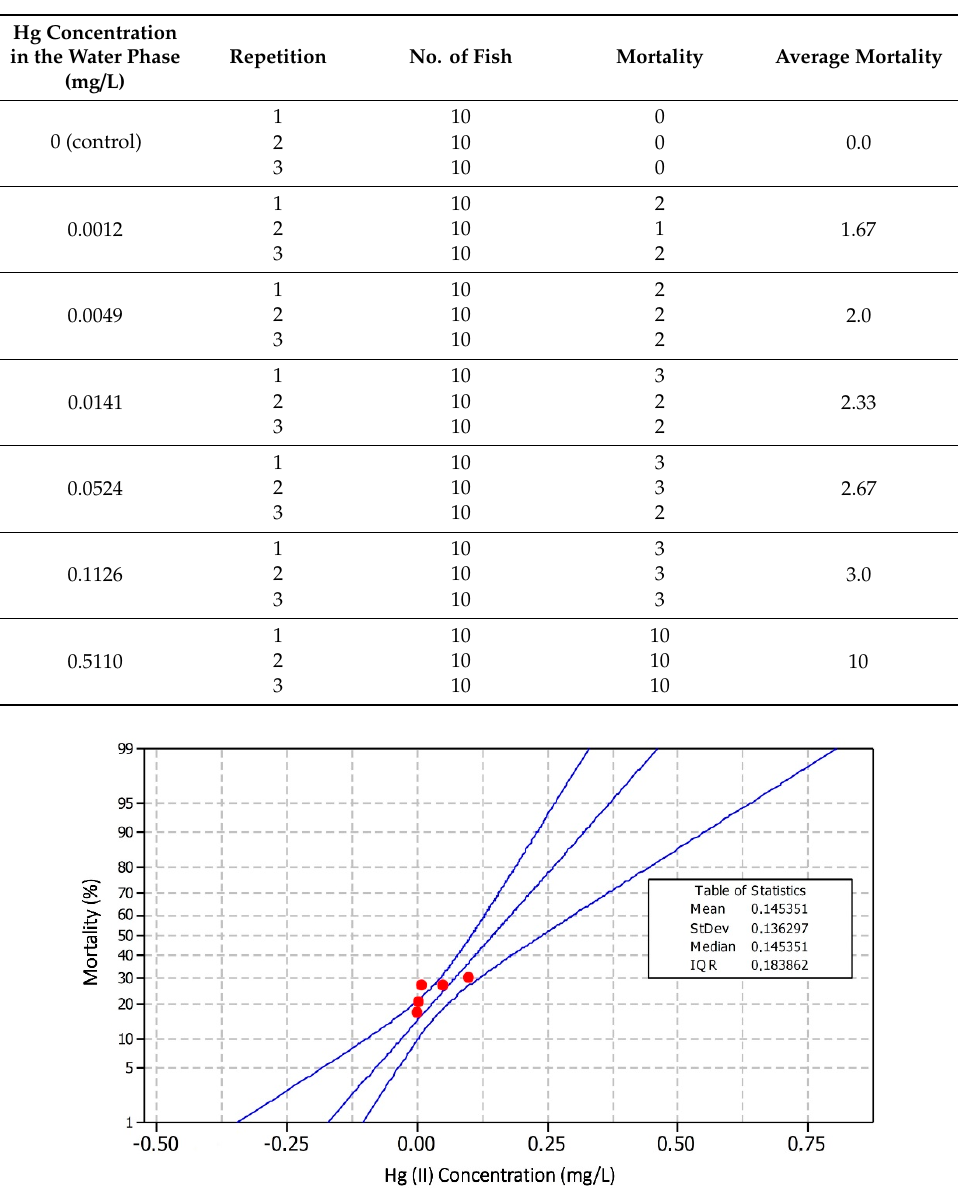
Figure 1. Linear regression probit model test, LC 50 Hg concentration to mortality of freshwater fish, Oreochromis niloticus (probability plot for mortality, normal 95% CI, probit data ML estimation). Table 1. Mortality of freshwater fish (Oreochromis niloticus) during 72 h toxicity test.